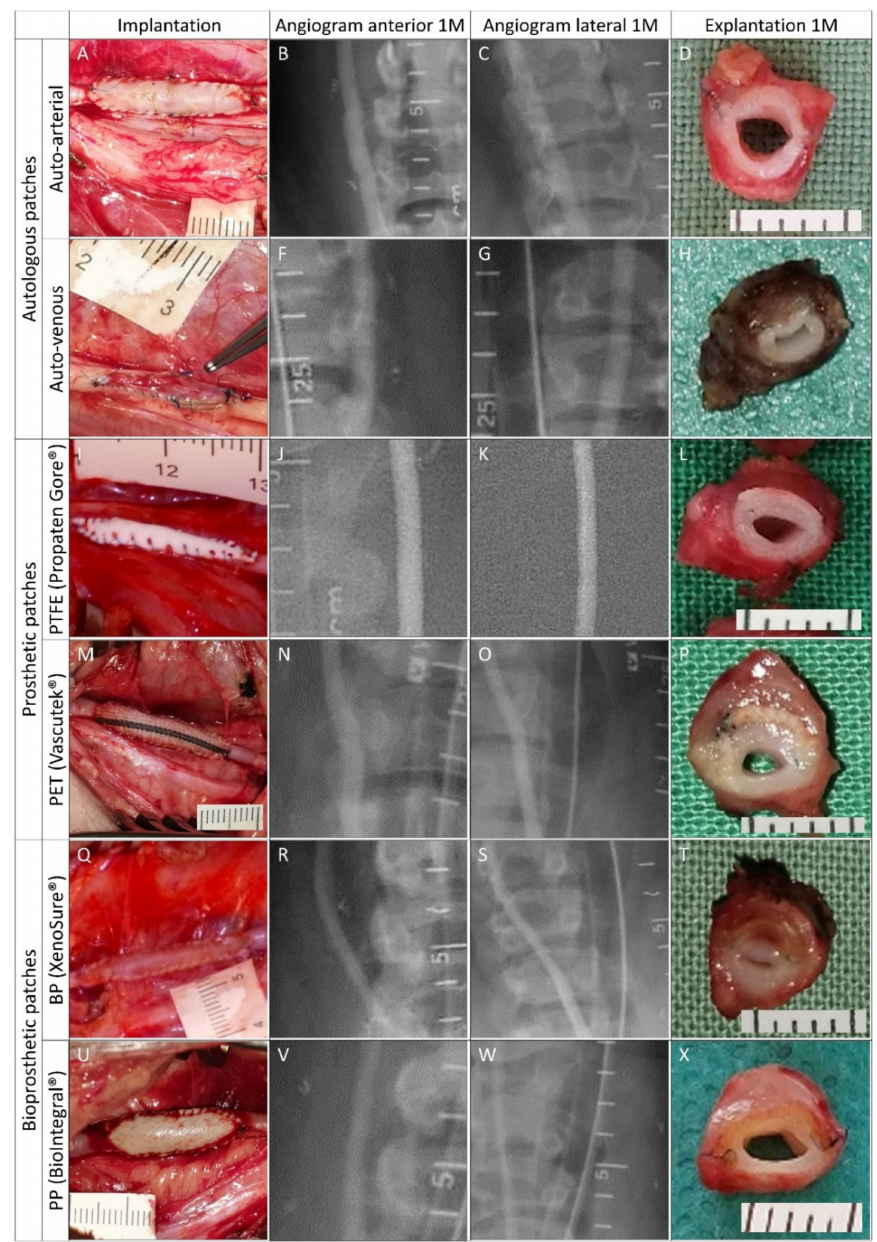
Figure 5. Clinically used vascular patches in porcine carotid arteries: implantation, pre-explant an- giography, and explantation. We implanted two types of autologous patches: ( A – D ) arterial autograft and ( E – H ) venous autograft; two types of prosthetic patches: ( I – L ) expanded polytetrafluoroethy- lene (ePTFE, Propaten ® Gore ® ) and ( M – P ) polyethylene terephthalate (PET, Vascutek ® ); and two types of bioprosthetic patches: ( Q – T ) bovine pericardium chemically stabilized with glutaraldehyde (BP, XenoSure ® ) and ( U – X ) detoxified porcine pericardium (PP, BioIntegral ® NoReact ® ). Macro- scopic views of the patches after declamping and hemostasis during implantations are shown in the left-hand column. Selective carotid angiograms performed from groin access at 1 month (1 M) post- implantation are shown in the middle two columns (anterior–posterior and lateral projections). The boundaries of the implanted patch are marked with metal clips. Gross appearances of cross-sectioned explants at 1 M are presented in the right-hand column. Implanted patches comprise the upper half of the vessel. Since the angiograms turned out normal (R and S), the apparent lumen loss in T was probably due to spasms during